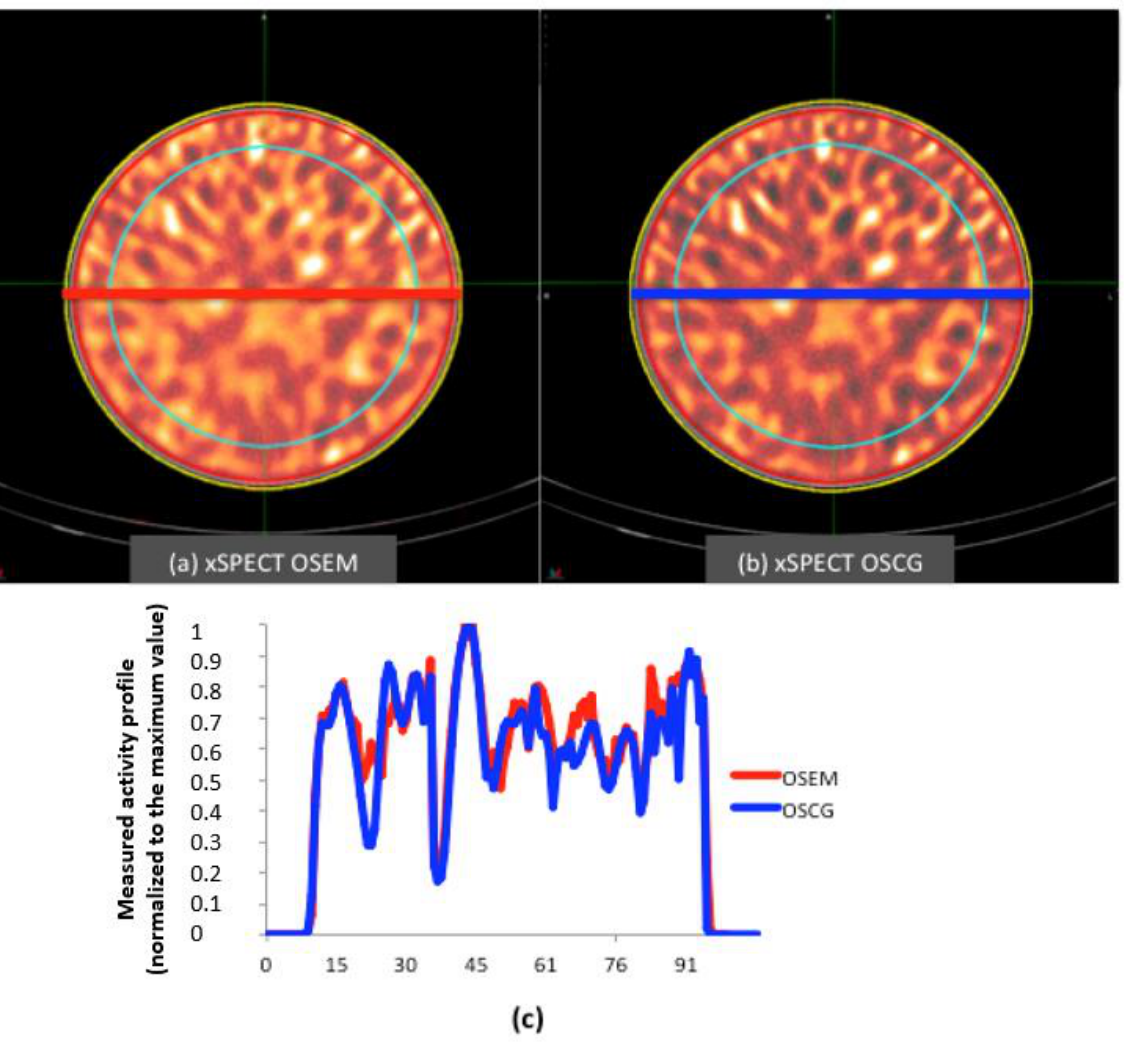
Figure 7. ( a ) Profiles generated at a central slice of the homogeneous phantom reconstructed with the xSPECT software using OSEM algorithm (blue line) with respect to ( b ) OSCG algorithm (red line); ( c ) Activity profiles.